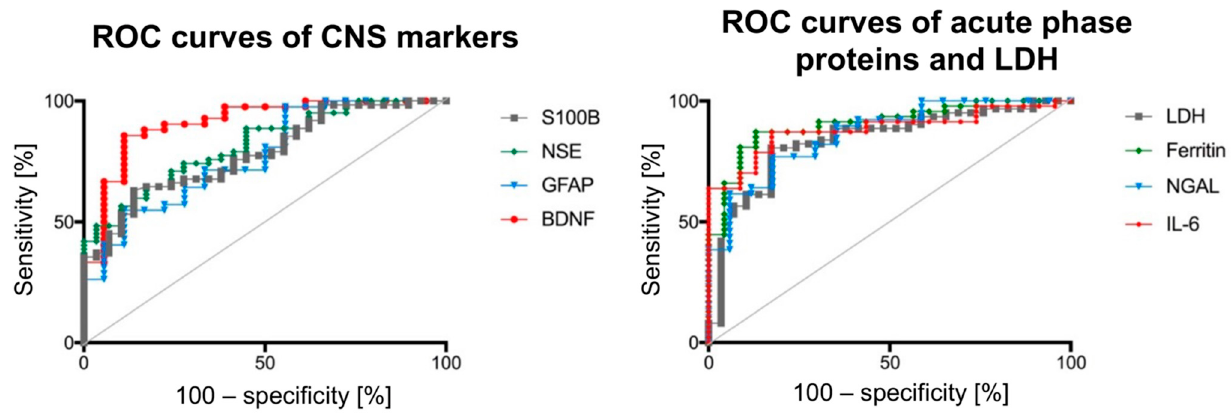
Figure 2. The receiver operating characteristic (ROC) curves for the biomarkers in this study are depicted. The survival times for TBIs and control cases were comparable (<2 h).